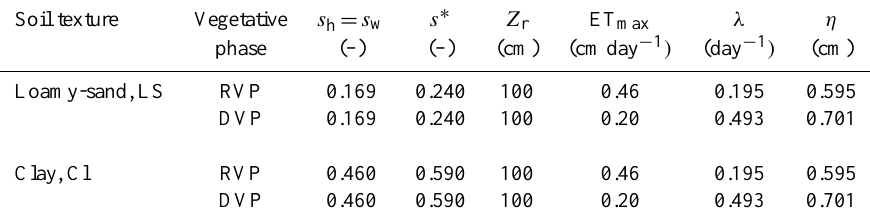
Table 2. BM hydrologic